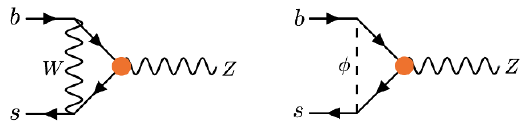
Figure 4 . Diagrams generating contributions to b ! sl + l (cid:0) from Q (1) fourth diagram should be taken to include all other Z penguin diagrams (including those with self-energies on external legs) where these operators a(cid:11)ect the Zl + l (cid:0) vertex.